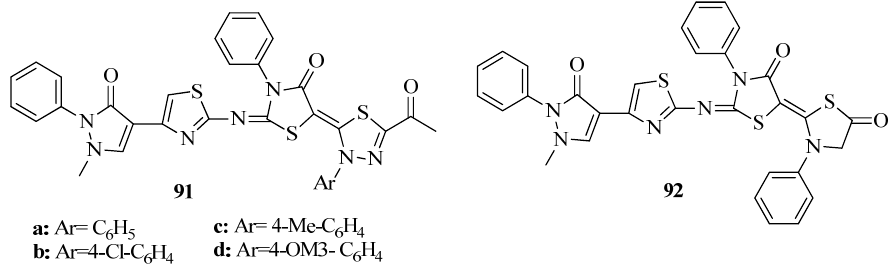
Figure 36. Structures of bis-1,3-thiazole derivatives.